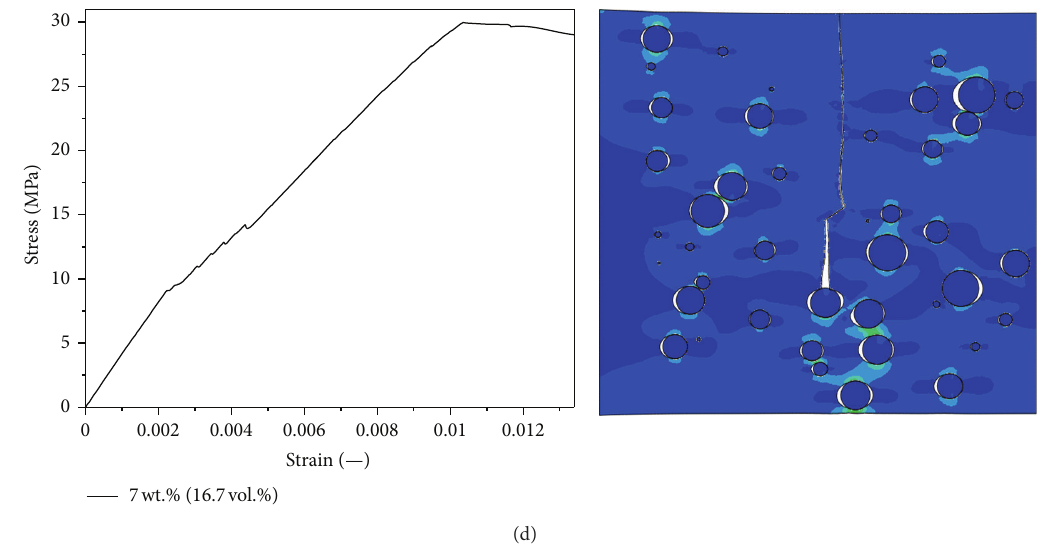
00.511.522.533.54